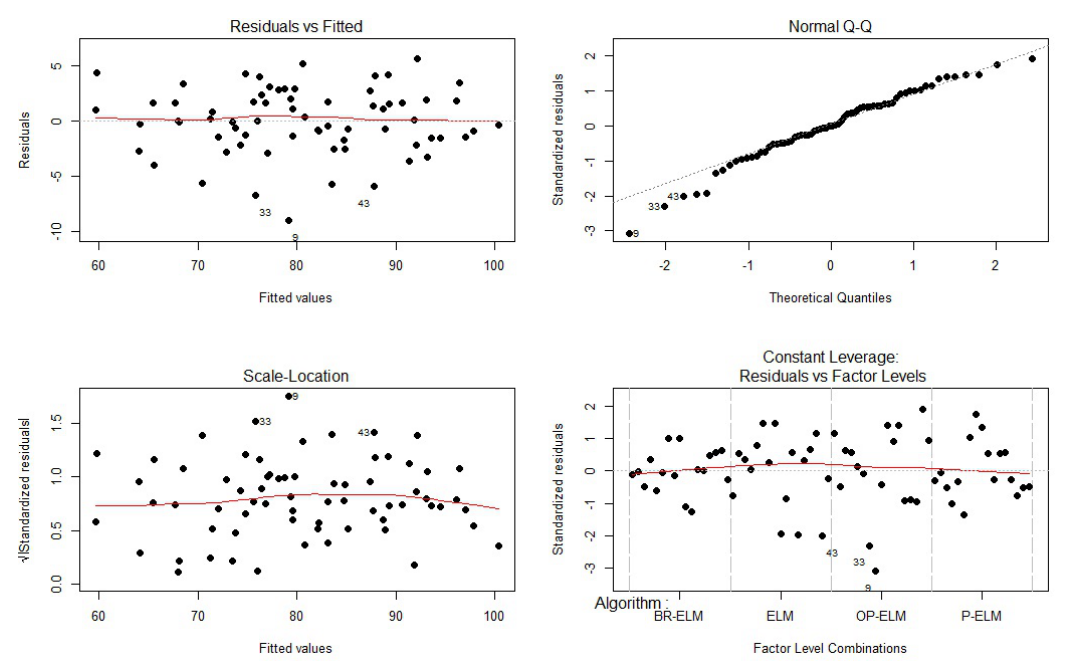
Figure 7. Validation results of the ANOVA test.